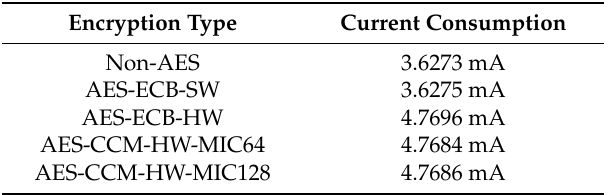
Table 3. Average current consumption of different encryption types.